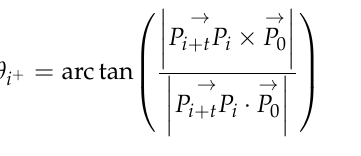
The back chord inclination angle (the angle between the blue arrow and the red arrow) was calculated using Equation (12).